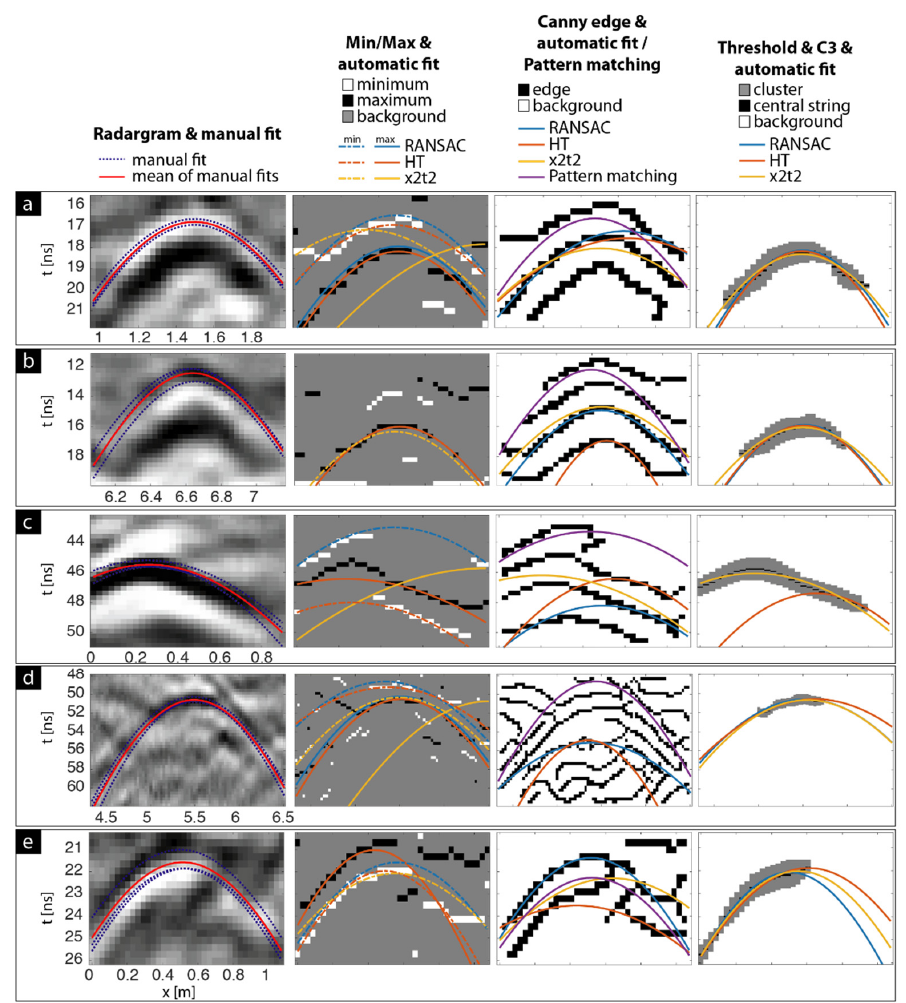
Figure 7. Exemplary detected hyperbolae with manual and automatic fitting results for all methods. The examples range from clearly visible hyperbola ( a , b ) to partly cut ( c ) and one-sided hyperbola ( e ). An example with noisy background is shown in ( d ). If a hyperbola for one fitting method is missing, the determined parameters are outside the valid range.